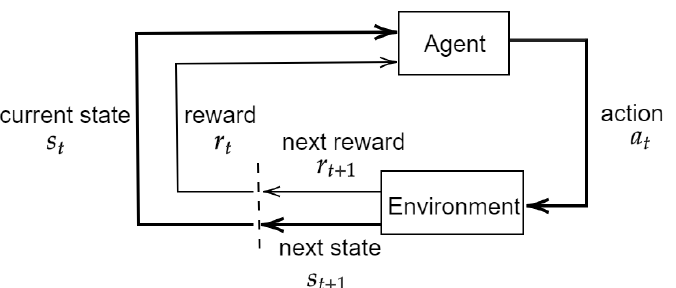
Figure 8. Interaction of the agent with the environment [38]. The agent chooses an action a t in the current state s t based on a policy. The environment receives the action and the current state and outputs the next state and the reward. Reprinted with permission from ref. [38]. Copyright 2022 Elsevier.